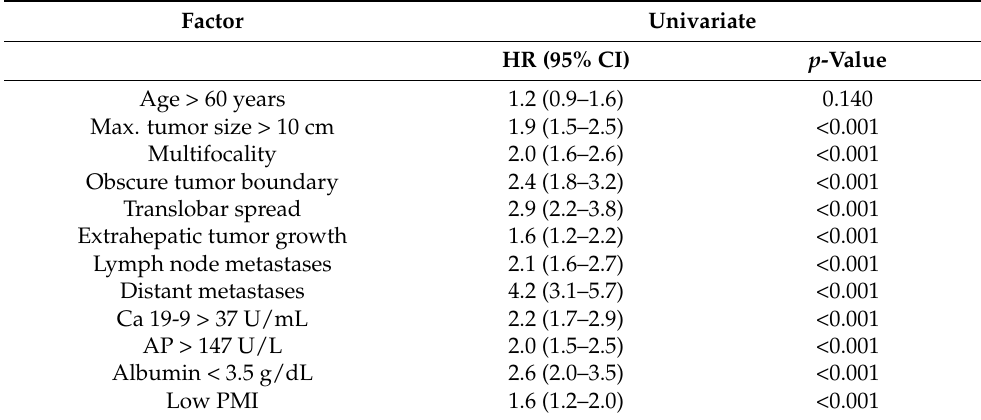
Table 2. Univariate Cox hazard regression model